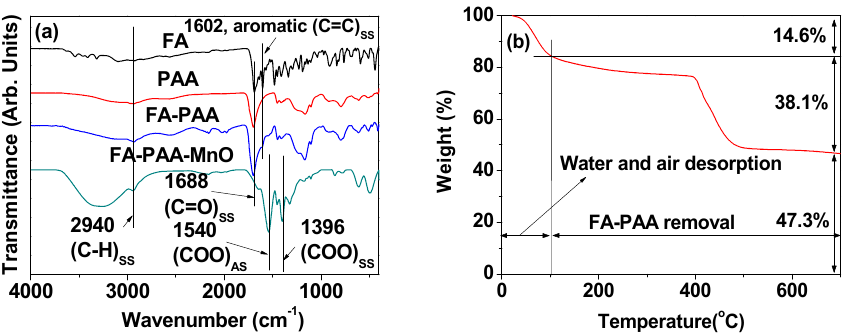
Figure 5. ( a ) FT-IR absorption spectra of the FA-PAA-coated MnO nanoparticles, FA, PAA, and FA-PAA. The subscripts, “AS”: Antisymmetric stretch and “SS”: Asymmetric stretch. ( b ) TGA